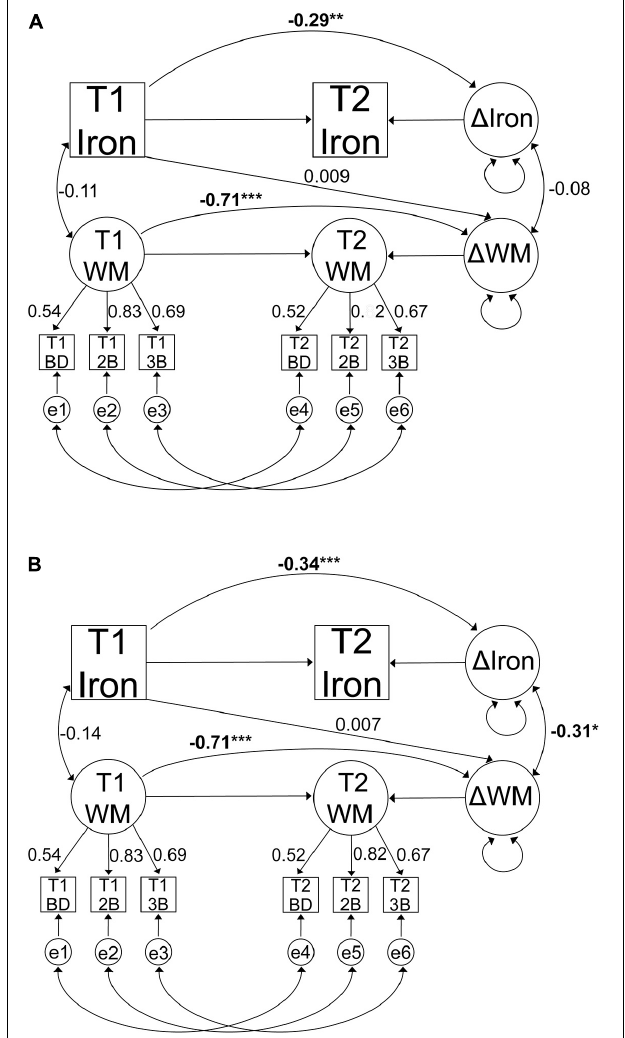
FIGURE 2 | Graphical representation of the change regression model for iron accumulation and working memory change in (A) striatum and (B) DLPFC. Observed variables are indicated by boxes and latent factors are indicated by circles. Regressions are indicated with one-headed arrows and covariances with two-headed arrows. Figures present standardised parameter estimates. All models were adjusted for age, sex, and education, as well as change in grey-matter volume in case of iron accumulation. T1, baseline; T2, follow-up; e, error term; WM, working memory; BD, binding task; 2B, 2-back task; 3B, 3-back task. (* p < 0.05, ** p < 0.01, *** p <